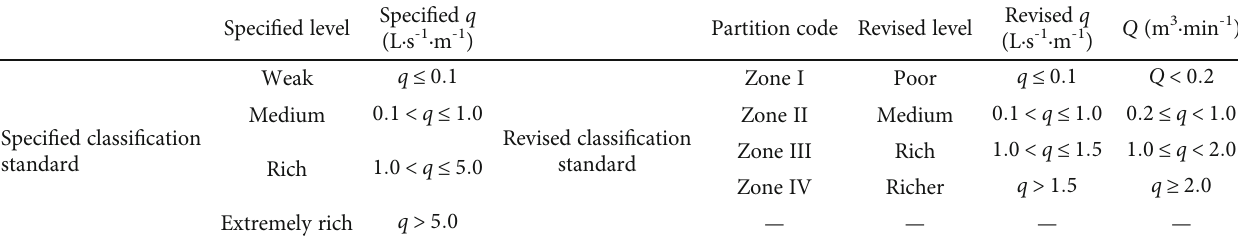
Table 7: Speci fi ed and revised classi fi cation standard for the water